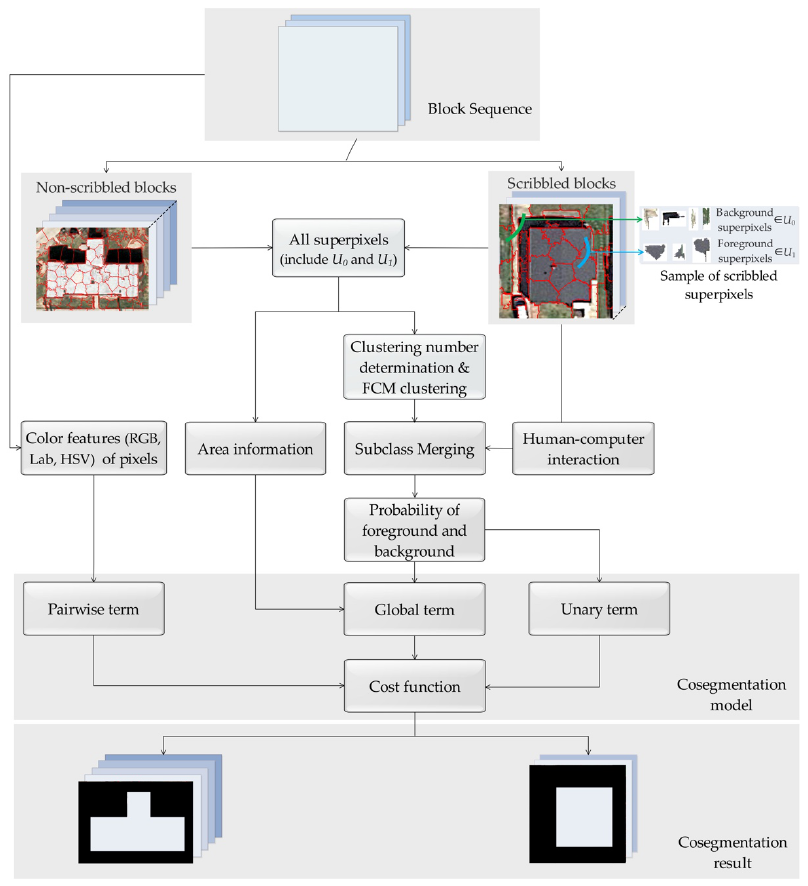
Figure 4. Clustering-guided co-segmentation.